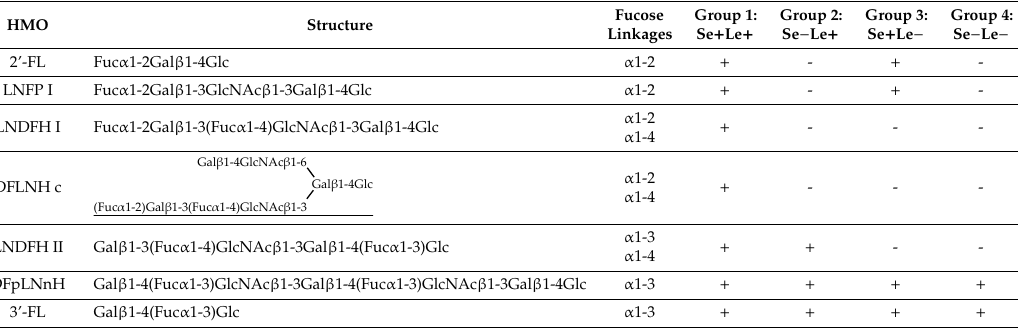
Table 1. Fucosylated Human milk oligosaccharides (HMOs) profile utilized to assign the Secretor and Lewis phenotype of the lactating mothers.